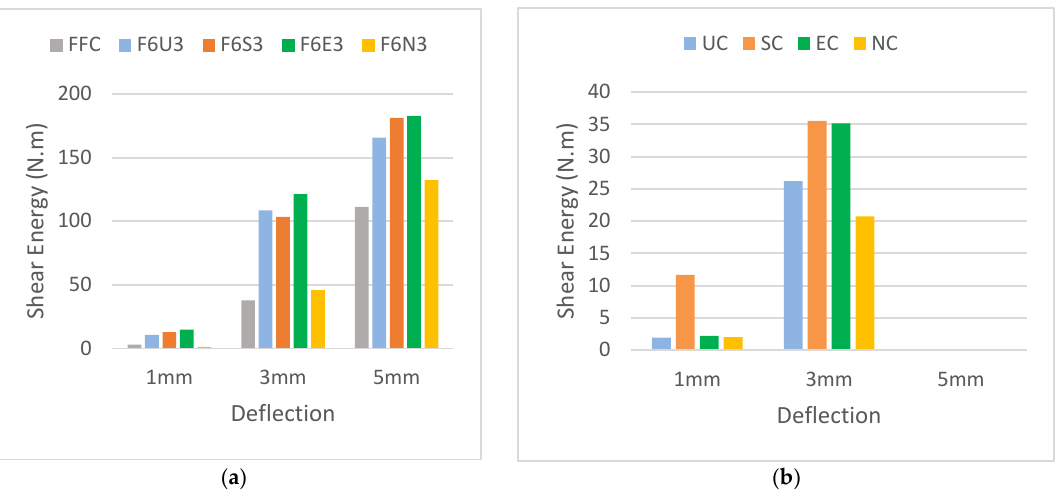
Figure 9 . The shear energy comparison for ( a ) HyFRC specimens and ( b ) single-fiber FRC specimens. Figure 9b presents the energy absorption capacity of the controlled single-fiber